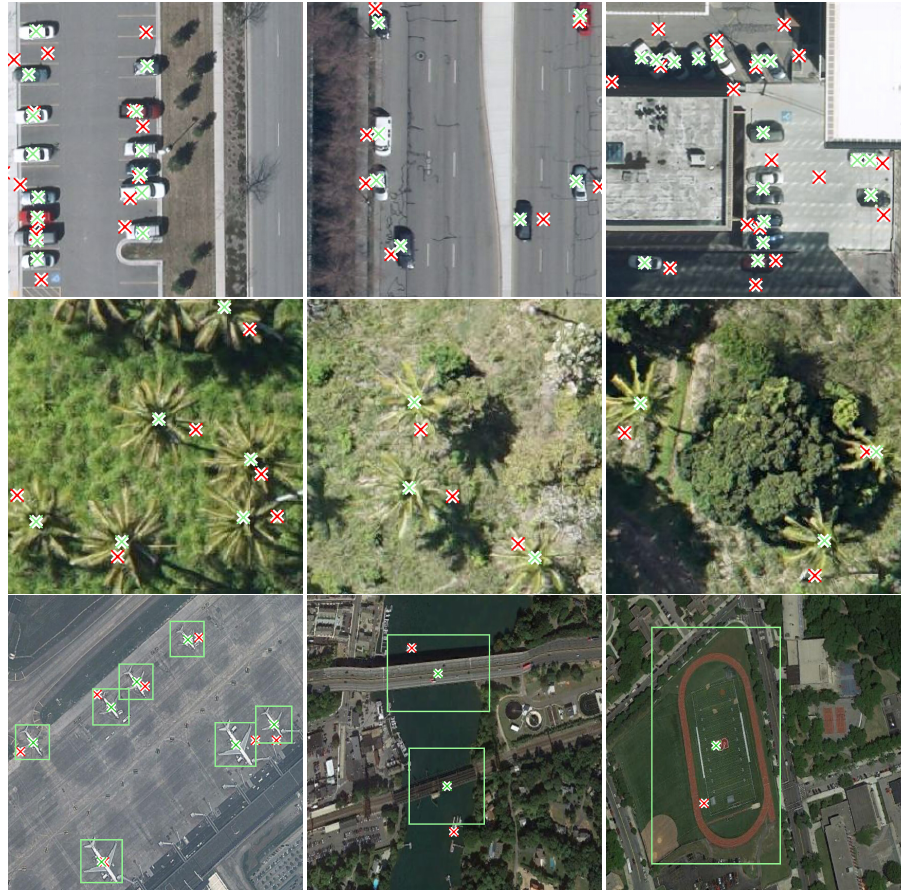
Figure 4. Corrected labels for examples of the COWC ( first row ), PalmTrees ( second row ), and NWPU VHR-10 ( third row ) dataset. Original noisy and refined labels are marked with red and green crosses, respectively. For the NWPU VHR-10 dataset, we additionally depict our estimated bounding boxes. Best viewed in color.